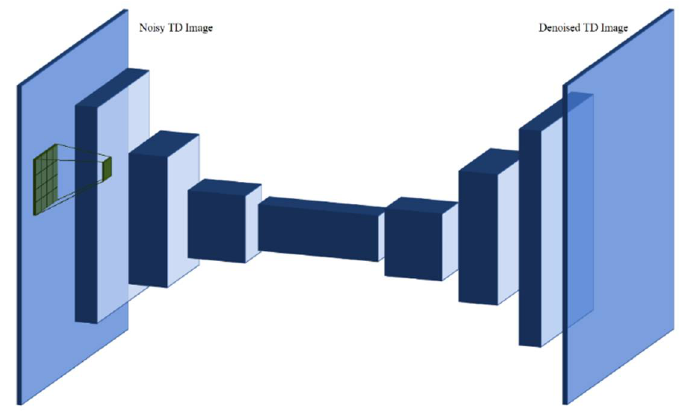
Figure 7. The architecture of convolutional denoising autoencoder used in [88].